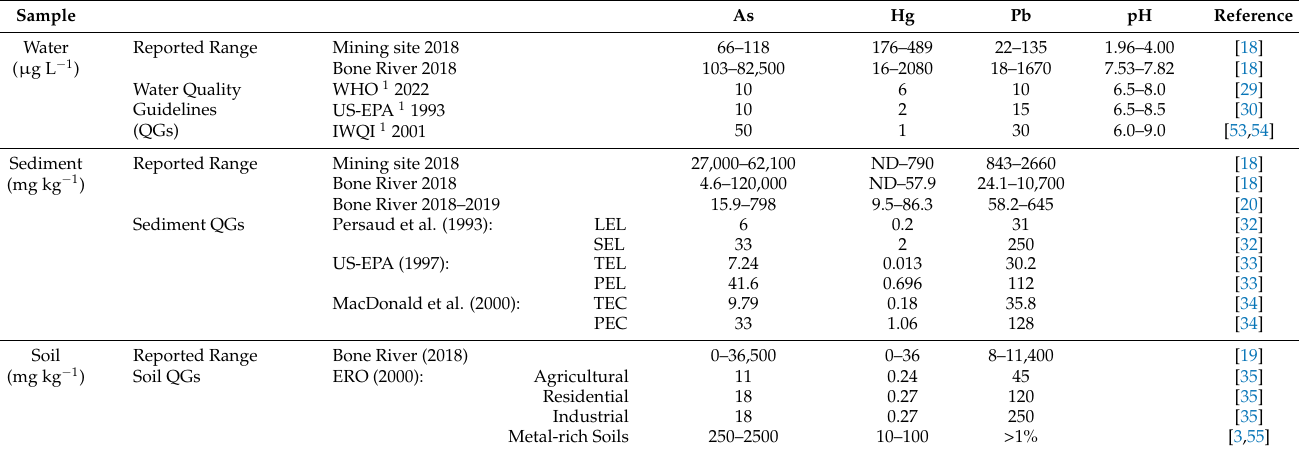
Table 2. Potentially toxic element concentrations (As, Hg, Pb) in water, sediment, and soils and pH (water) in the study area and various world